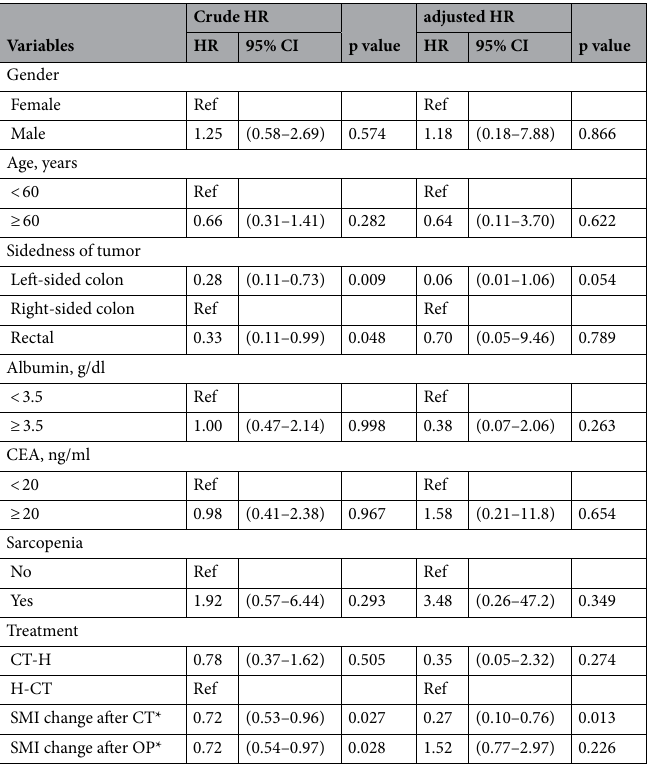
magnitude of change in SMI was positively correlated with OS (Fig. 3B,C).